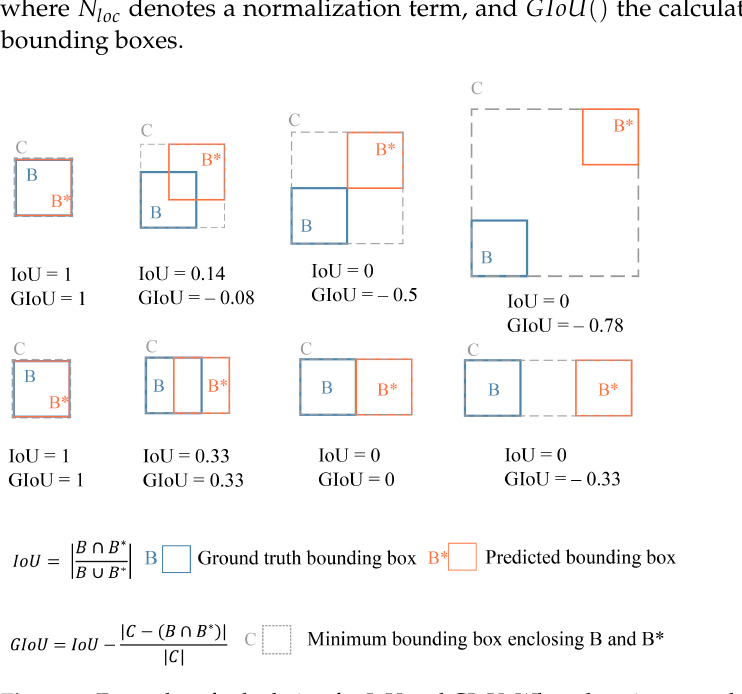
Figure 3. Examples of calculation for IoU and GIoU. When there is no overlap between the predicted and ground reference bounding boxes, the IoU value is zero and cannot reflect the distance between two boxes, whereas GIoU can reveal how far one box is from anther and has a non-zero